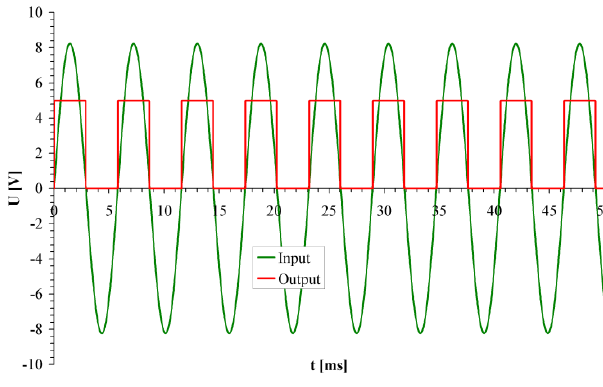
Fig. 8. Conversion of an analogue signal carrying information through frequency into a binary signal with an amplitude of 5 V